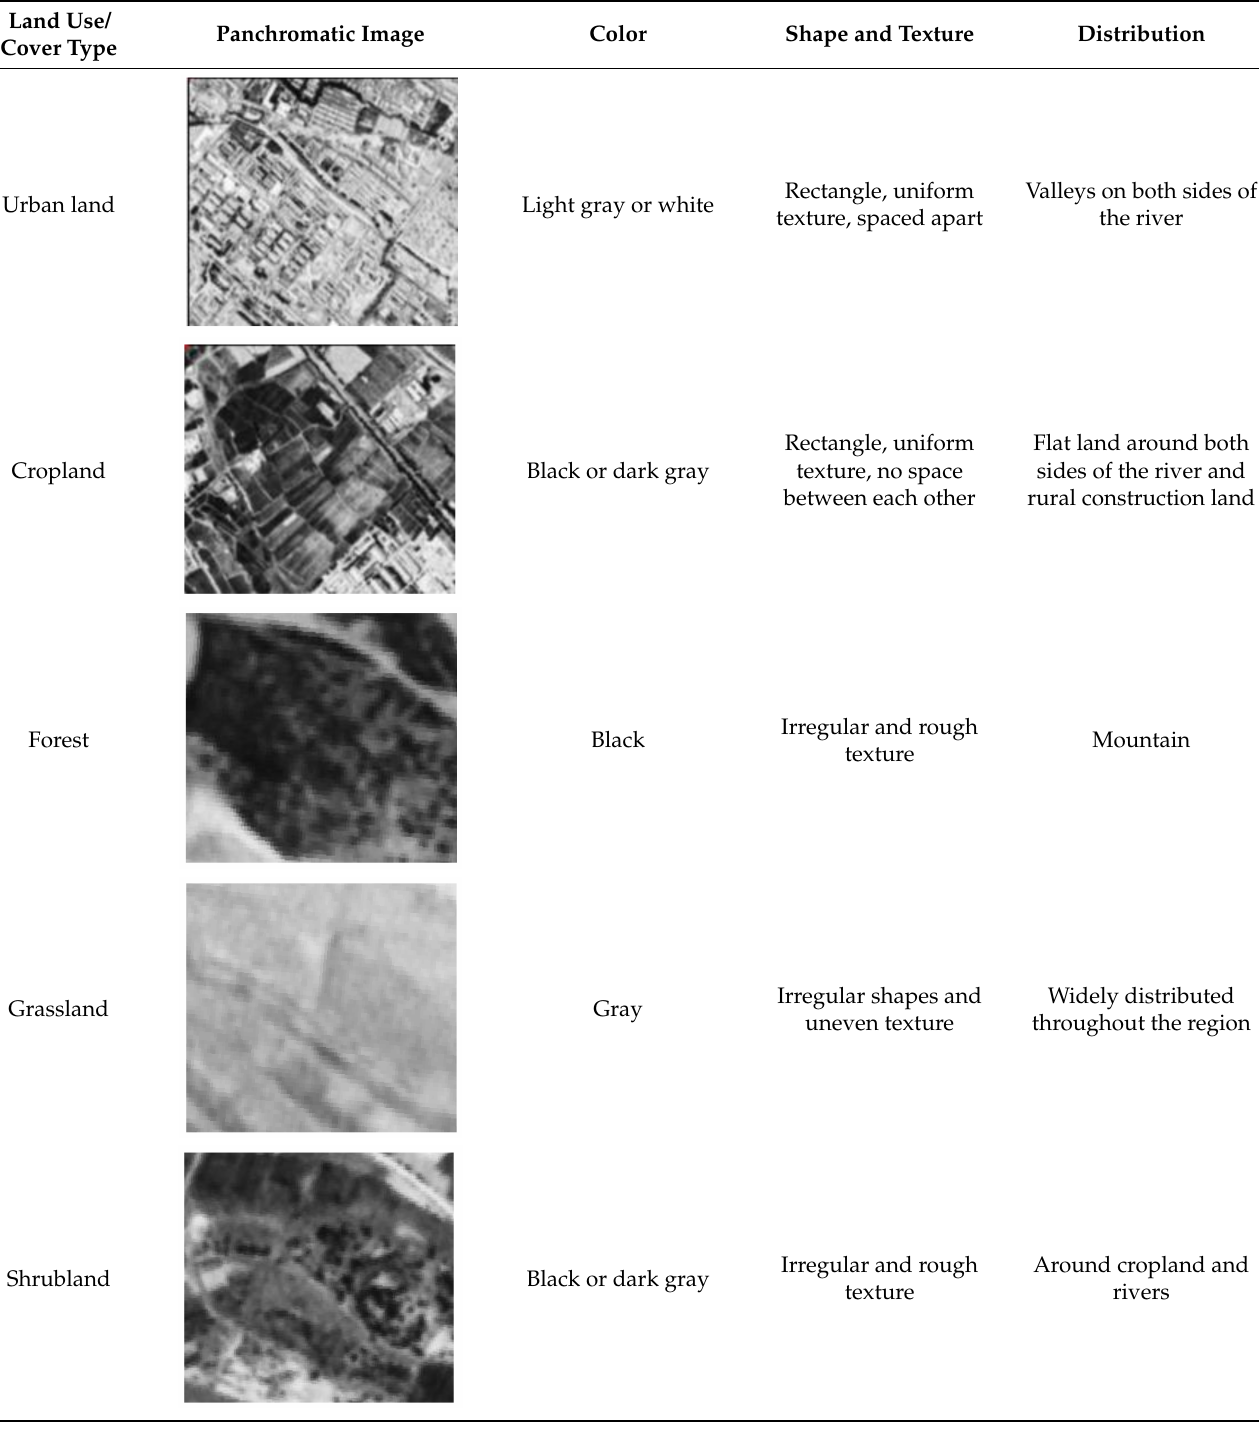
Table A1. Interpretation standards for Keyhole satellite